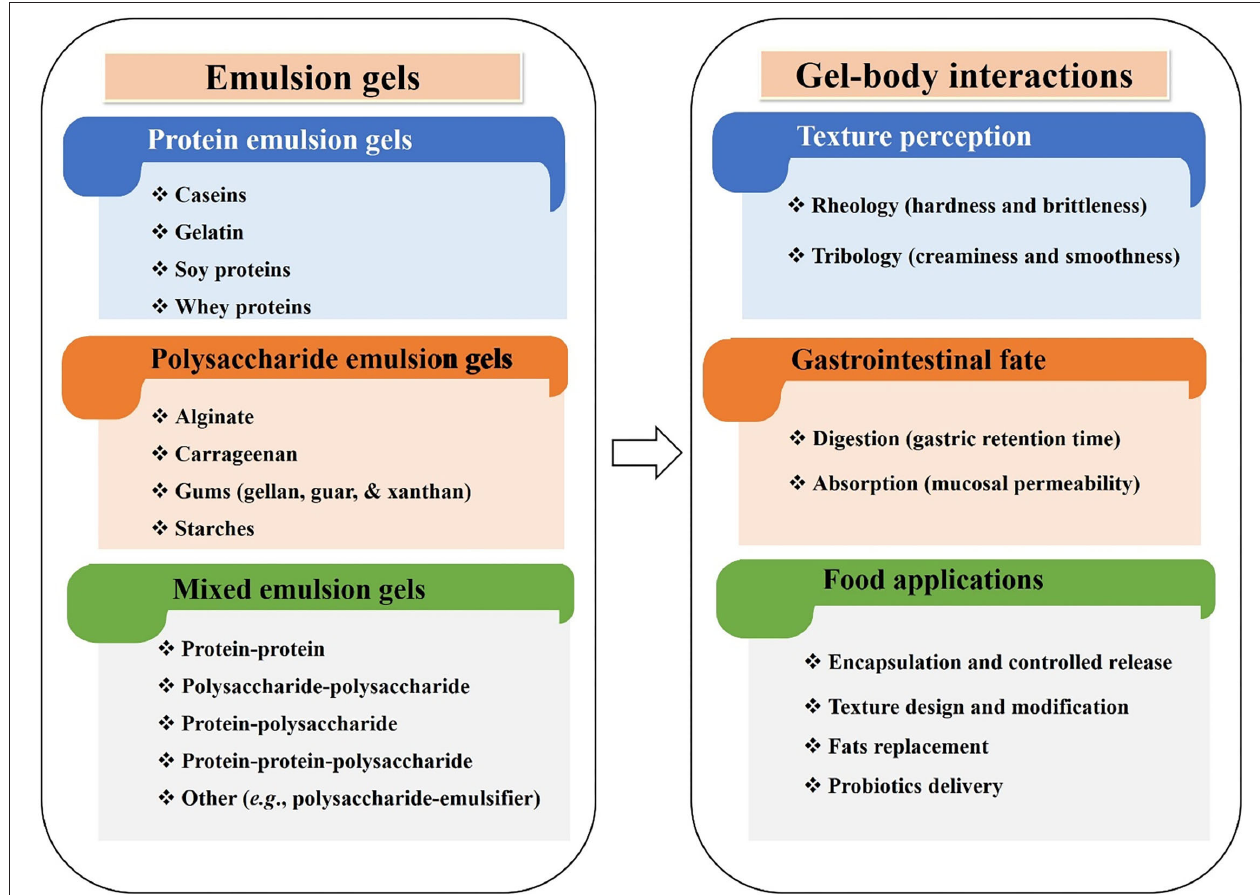
FIGURE 3 | An overview of emulsion gels, indicating their classification, gel-body interactions (texture perception, digestion, and absorption), and emerging industrial food